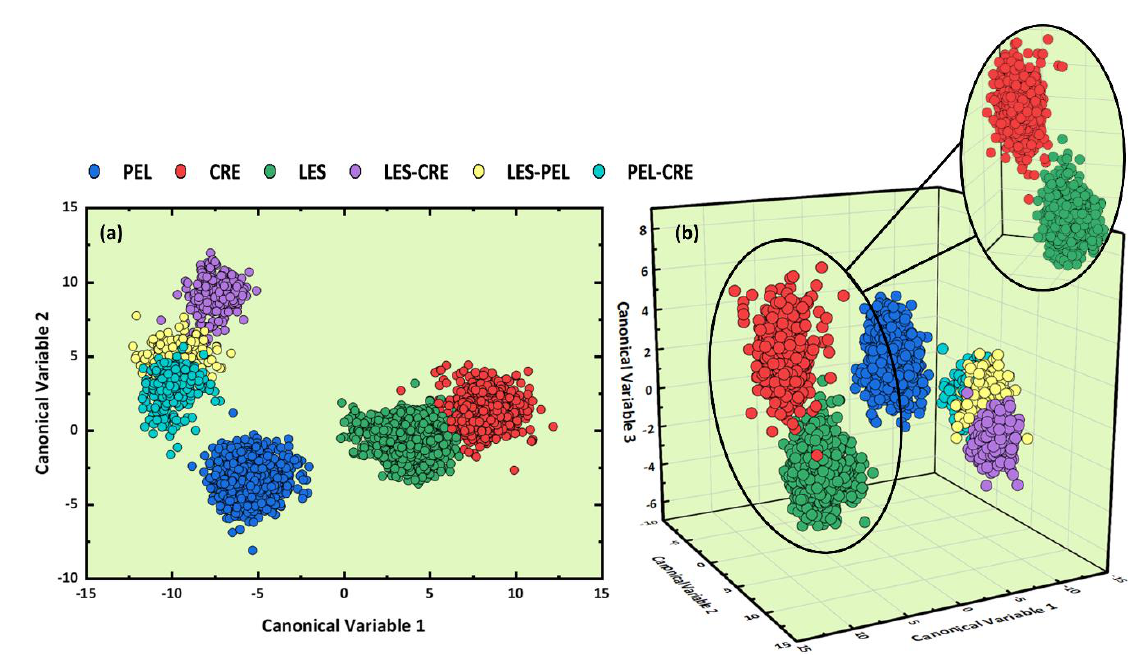
Figure 3. ( a ) 2D and ( b ) 3D LDA plots obtained using the olive oils’ LIBS spectra.